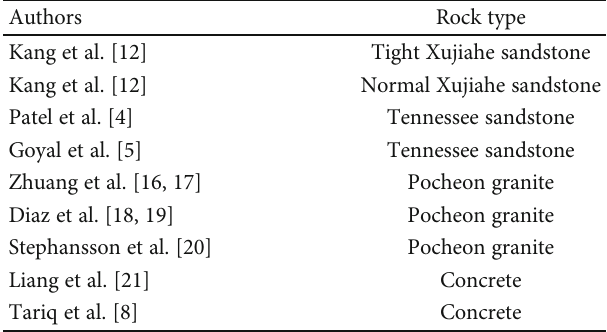
Figure 8: Correlation between breakdown pressure and tensile strength for conventional injection tests. The equation is calibrated based on Equation (1). Table 5: Sources of data for the cyclic injection curve fi tting (cyclic breakdown pressure/conventional breakdown pressure vs. number of